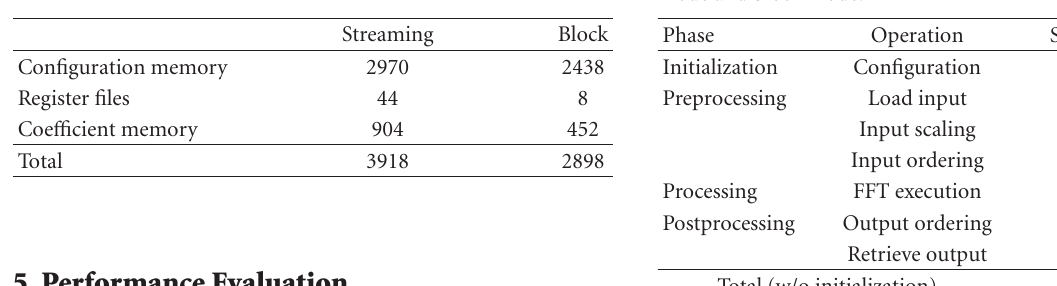
Table 5: Number of bytes required for configuration of the FFT- 1920.